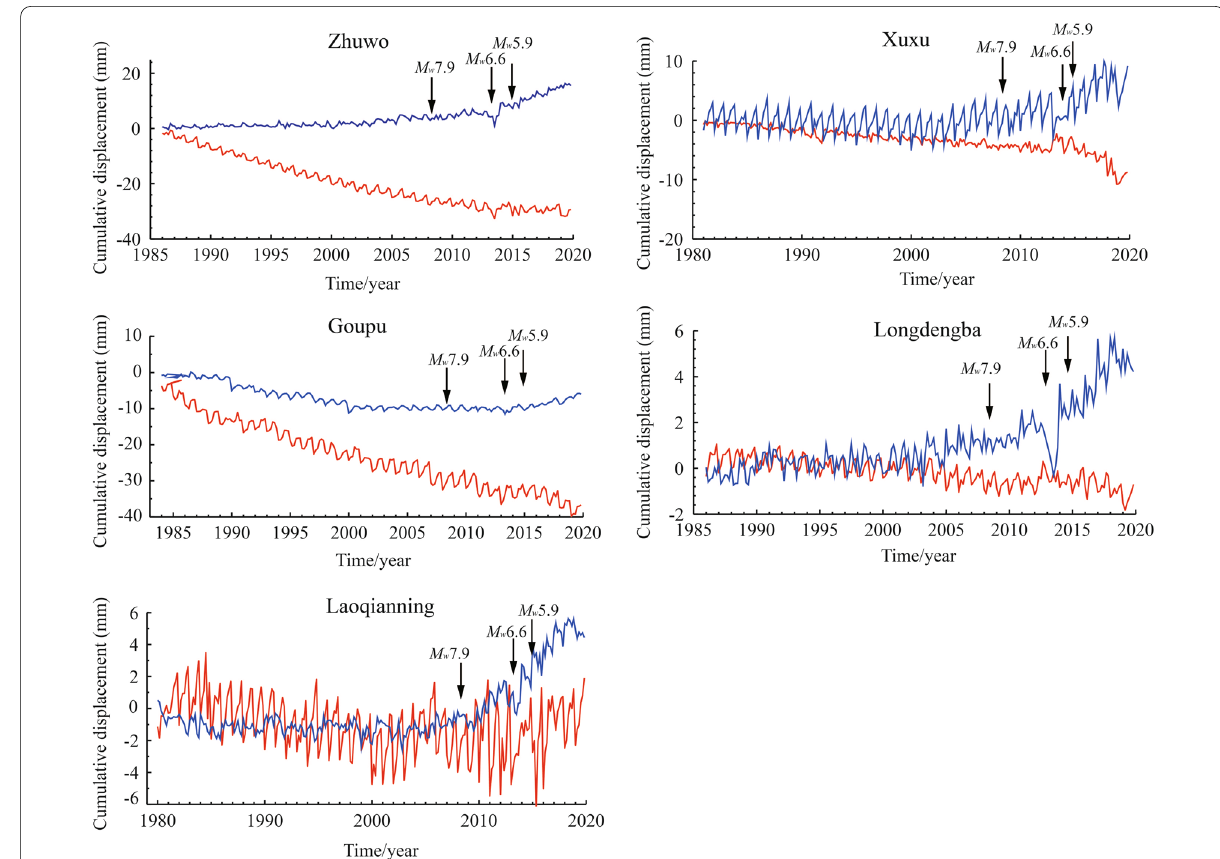
Fig. 10 Time series curves of the motion components of the Xianshuihe Fault Zone. The red line denotes the horizontal strike–slip component, and the blue line denotes the horizontal tension and compression